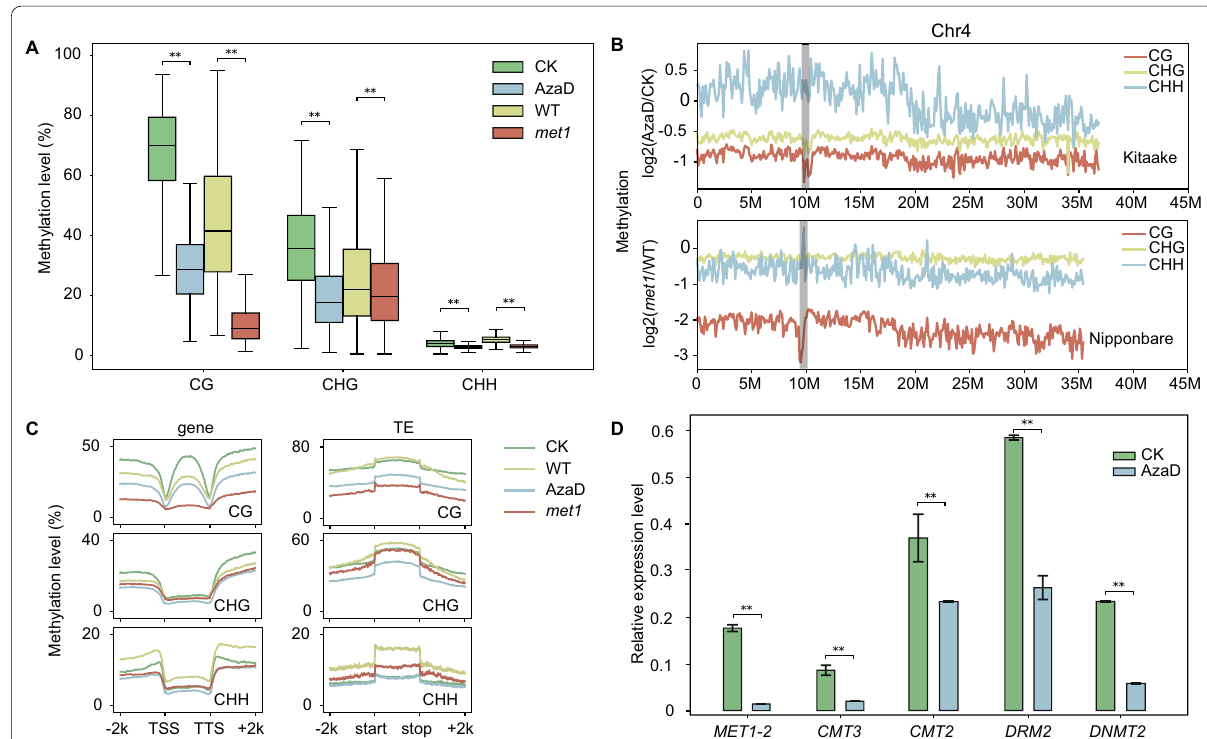
Fig. 1 Methylation status was significantly reduced after AzaD treatment. a Boxplot of global methylation levels of CG, CHG, and CHH methylation in AzaD treated and osmet1-2 mutant rice. Methylation levels of the three contexts showed significant reductions in both AzaD treated and osmet1-2 rice. b Fold changes of methylation level for CG, CHG, and CHH methylation on chromosome 4. AzaD treatment induced moderate CHH methylation increases in the heterochromatin region. The grey boxes mark the centromere regions. c Metaplot of methylation levels in genes, TE bodies and their flanking regions. d Relative expression levels of selected methyltransferases. Transcript levels of MET1-2 , CMT3 , CMT2 , DRM2 , and DNMT2 were significantly reduced after AzaD treatment. * p < 0.05, ** p < 0.01 by Student’s t-test. CK and WT refer to check (CK, Kitaake without AzaD treatment) and WT (wild-type Nipponbare without mutation of MET1-2 ) plants,